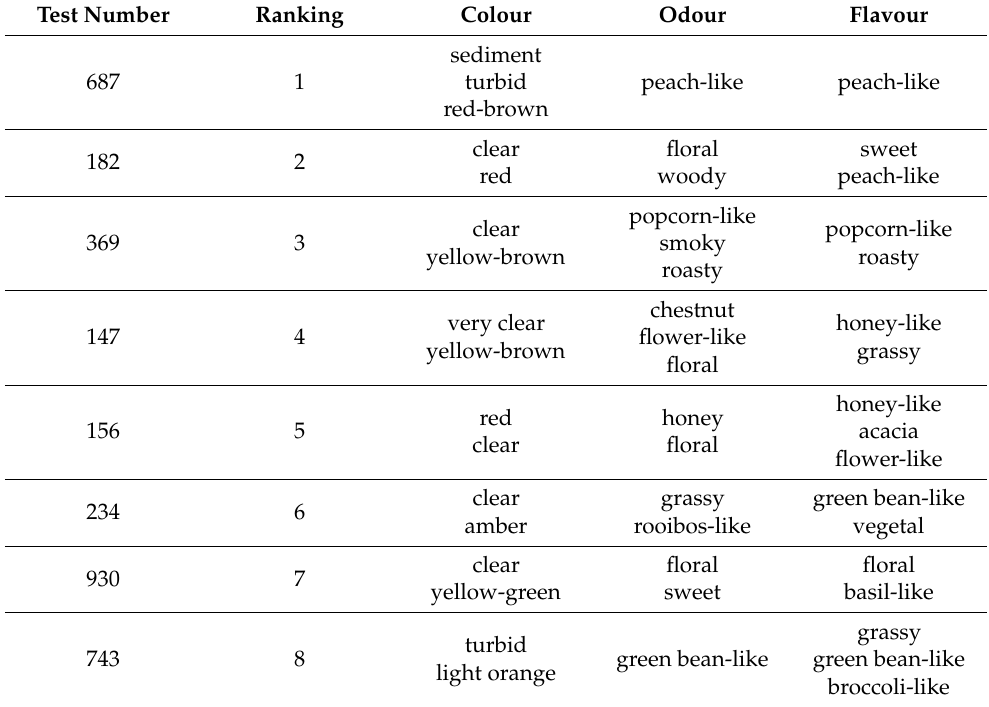
Table 5. Results of ranking test and descriptive terms for colour, odour (via orthonasal detection) and flavour (via retronasal detection) of the panel for the best 8 tea